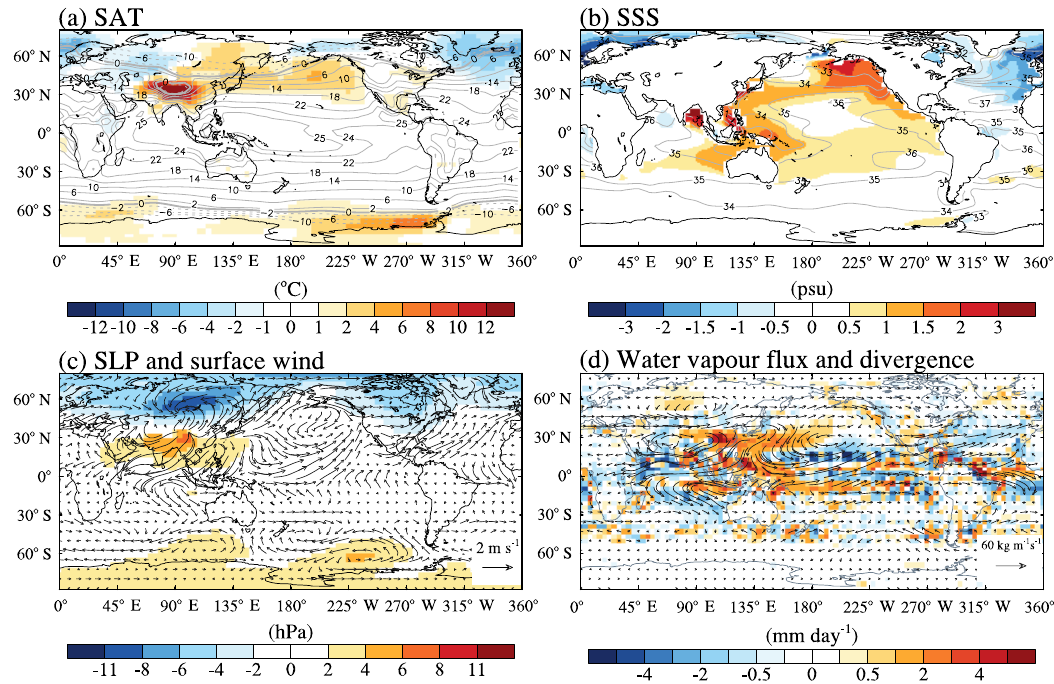
Figure 2. (a) Climatological SAT in MTP (contour) and anomalies (shaded) for NTP minus MTP; (b) same as (a) but for sea surface salinity (SSS); (c) changes in sea-level pressure (SLP, shading) and surface wind (vectors); and (d) vertically integrated (surface to 300hPa pressure layer) water vapor flux (vectors) and its convergence (shading) in NTP relative to MTP. Unit of convergence is converted to millimeters per day assuming the density of liquid water as 1gcm − 3